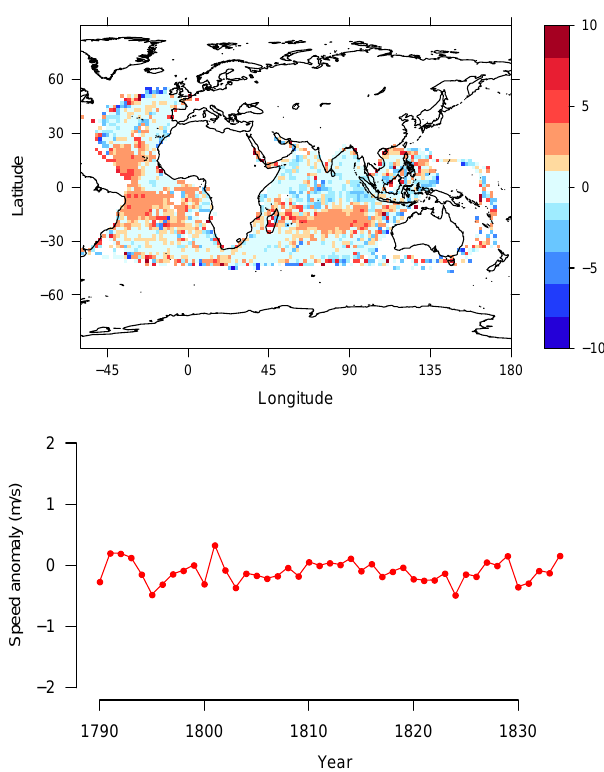
Fig. 8. Wind-speed (WS) anomalies (ms − 1 ): observations minus Fig. 8. Wind Speed (WS) anomalies (m/s): observations minus a a wind-speed climatology for 1961–1990 from the ERA-40 re- wind-speed climatology for 1961–90 from the ERA-40 reanalysis analysis (Uppala et al., 2005). Upper panel: truncated mean WS (Uppala et al., 2005). Upper panel: truncated mean WS anomaly in anomaly in each 2 × 2 degree square. Lower panel: truncated mean each 2x2 degree square. Lower panel: truncated mean WS anomaly WS anomaly in each in each year. Fig. 8. Wind Speed (WS) anomalies (m/s): observations minus a wind-speed climatology for 1961–90 from the ERA-40 reanalysis (Uppala et al., 2005). Upper panel: truncated mean WS anomaly in each 2x2 degree square. Lower panel: truncated mean WS anomaly in each year.